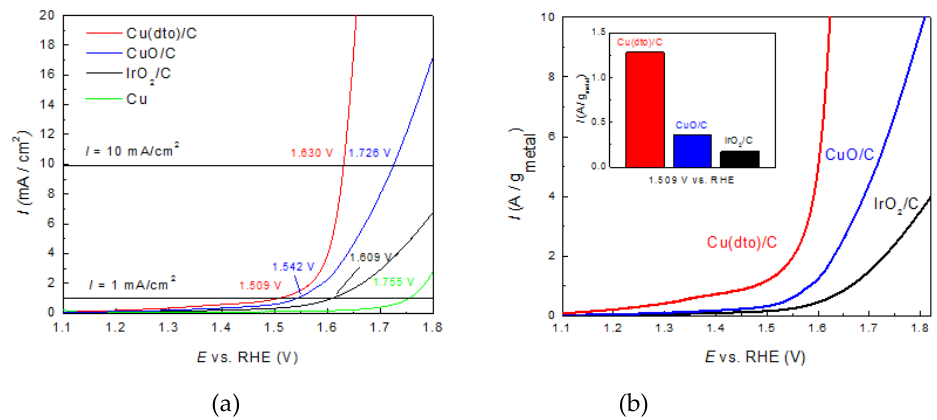
Figure 3. Linear sweep voltammetry (LSV) curves at a scan rate of 5 mV/s, conducted in N 2 -saturated 1 M KOH. ( a ) in the current per electrode surface area. ( b ) in the current per gram of the active metal. In the inset, the mass activity at 1.509 V is compared.